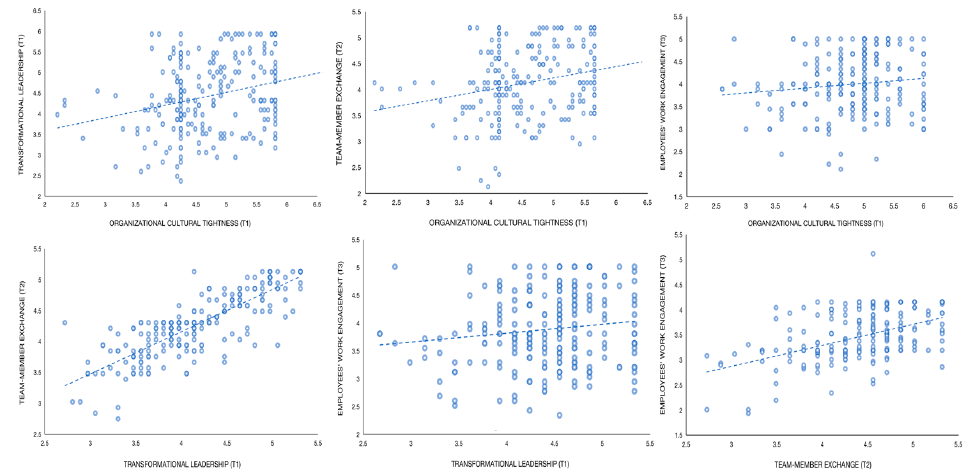
Figure 2. Scatter plot between variables.